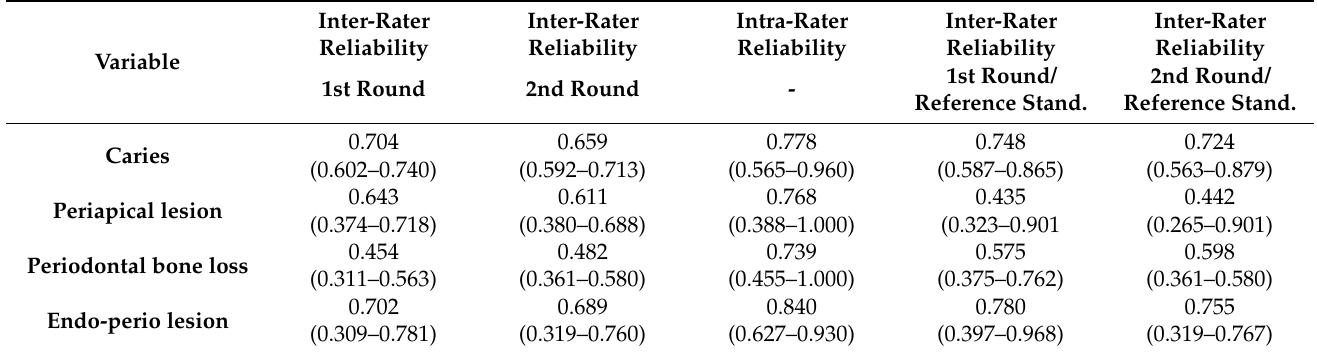
Table 5. CK means of the inter- and intra-rater reliability for the four dental pathologies.